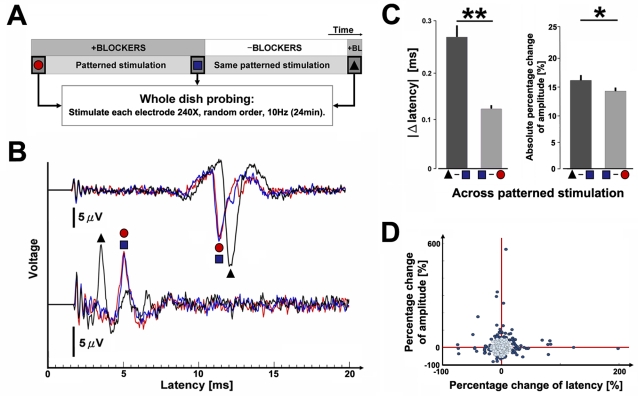
The cause of plasticity was neural activity, and the site of plasticity was not synaptic.(A) Experiment protocol. SAPs were blocked to eliminate the influence of ongoing synaptic activity, and 3 identical periods of whole-dish probing (shape and color coded) were applied before and after the 5 hours and 20 minutes of patterned stimulation (Fig. 3A). (B) Example extracellular voltage traces for two separate dAPs during each whole-dish probing period (240 traces averaged). Changes that accrued during the patterned stimulation persisted (blue square to black triangle): they were not reflections of ongoing synaptic activity. Changes were minimal during patterned stimulation in the presence of blockers (red circle to blue square): the accrued changes were not artifacts from the electrical stimulation or replacing media. (C) Statistics for all observations (mean+s.e.m. **P<1e-6 and *P = 0.003. Wilcoxon signed rank test for paired samples. n = 904 dAP trains. 5 cultures from 3 dissociations). (D) Changes in latency were not monotonically correlated to changes in amplitude (P = 0.22, ρ = 0.04; Spearman's rank correlation coefficient). The outlying data points, using an arbitrary cut-off at 10% of the distribution, were plotted with darker dots.